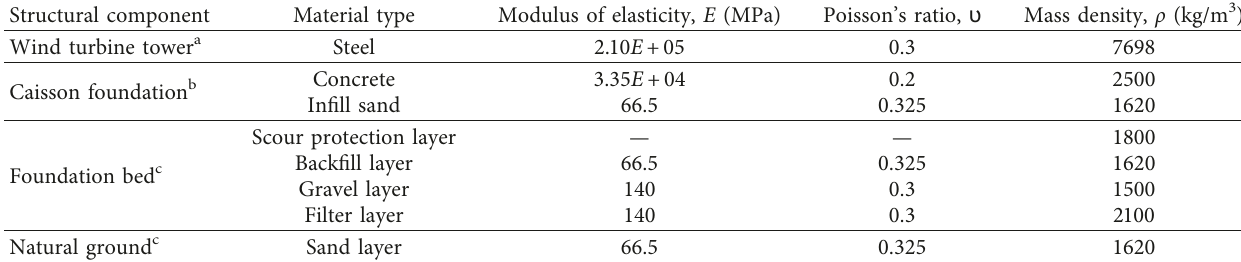
Table 2: Material properties of the wind turbine tower with caisson